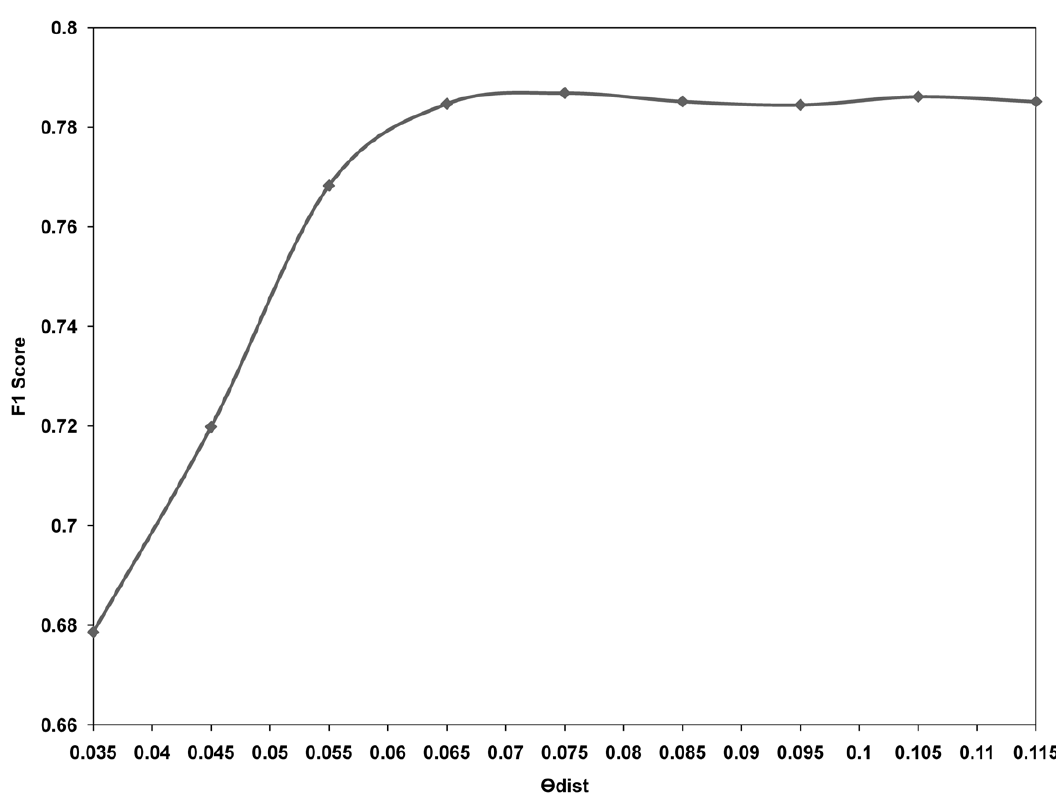
Figure 5. Maximum F1 score of MGVD for chromosome 22 according to various values of the two parameters, h dist and h CNVZ .